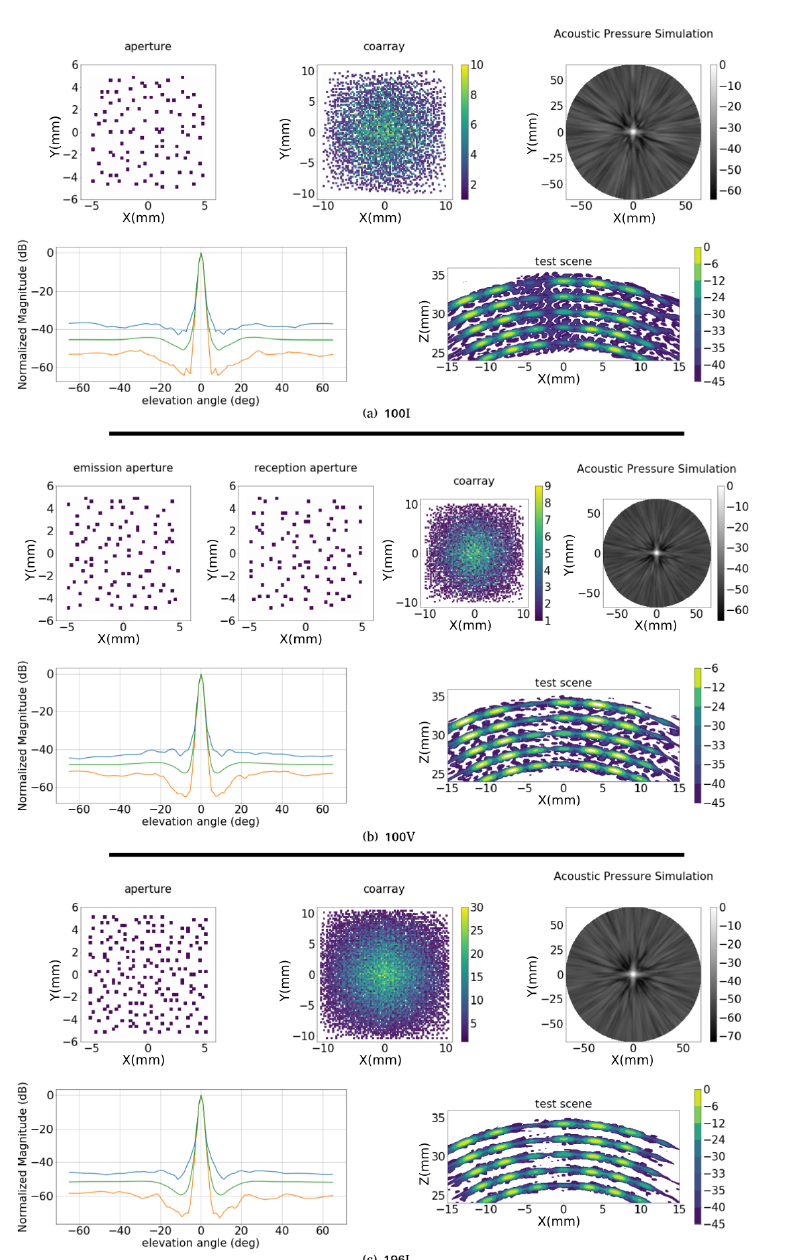
Figure 10. Optimization with coarray based fitness function. Best results for configurations ( a ) 100I, ( b ) 100V and ( c ) 196I. In each figure are presented: emission (and reception for 100V) apertures; coarray matrix representation; acoustic field in the semi-sphere; maximum (blue), mean (green) and minimum (red) lateral profile at each elevation angle; and image resulting from the test